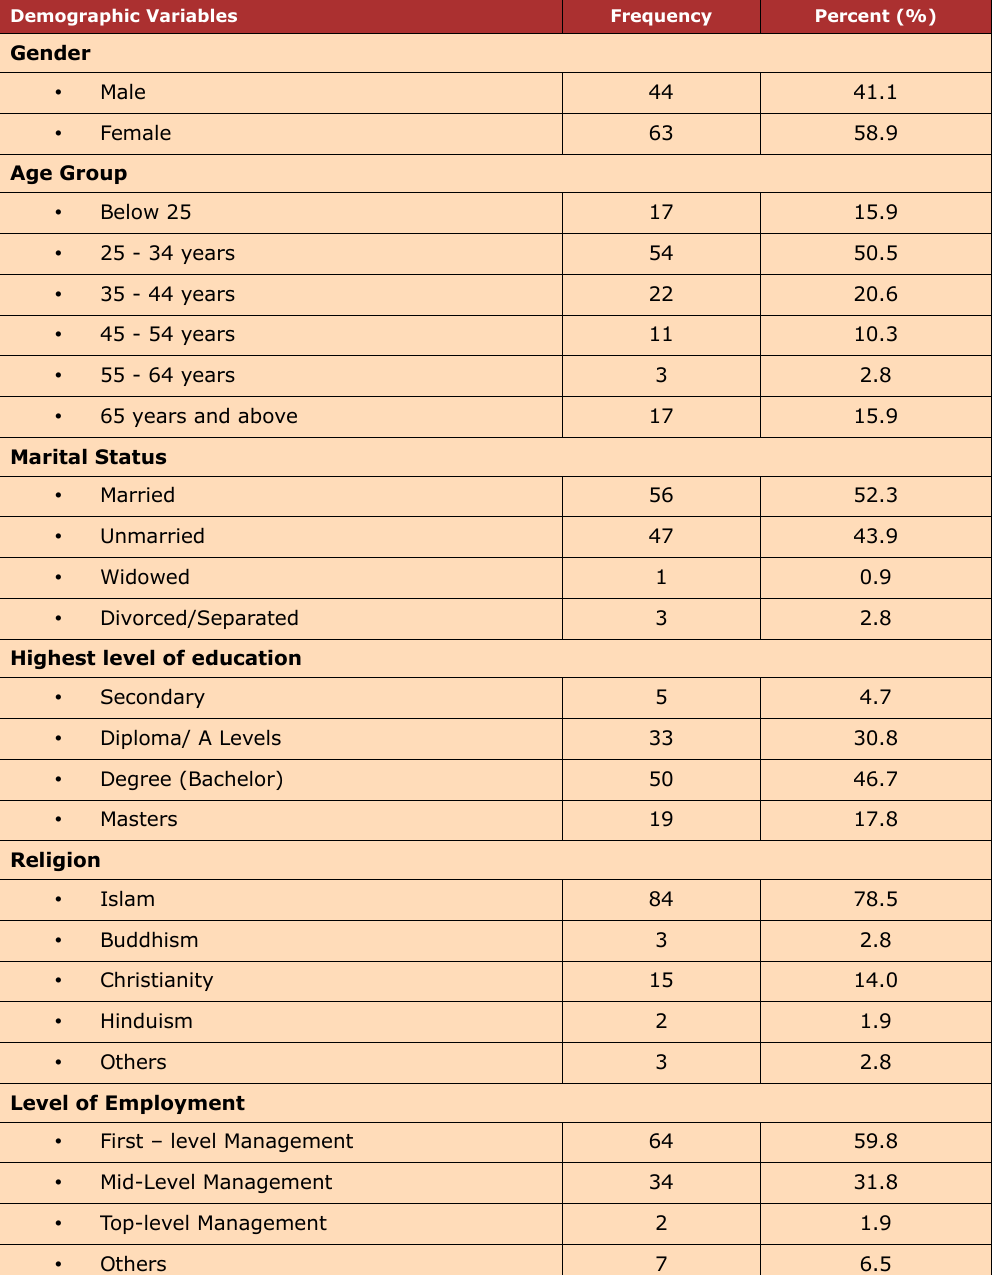
Table 1. Demographic Information of the